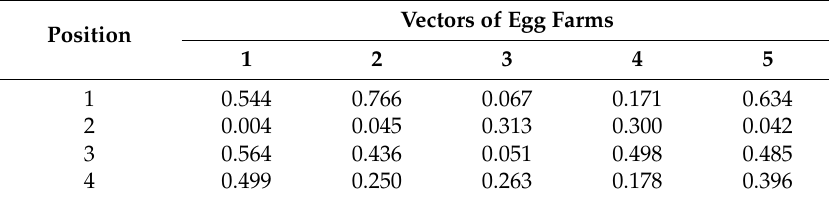
Table 3. Initial target vectors of egg